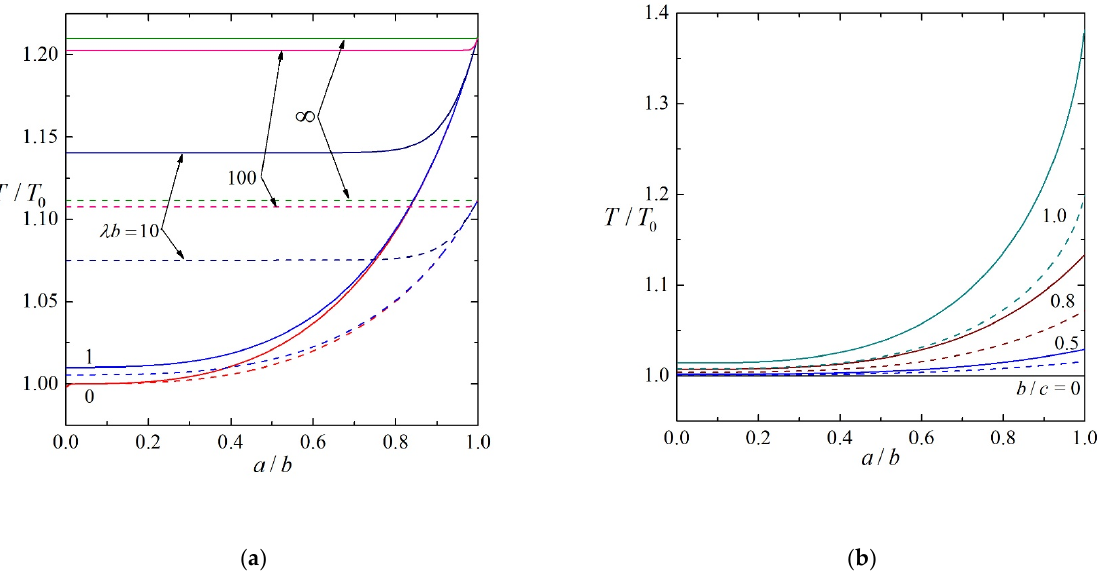
Figure 4. Normalized torque T / T 0 for a porous sphere ( a = 0) rotating about a diameter perpen- dicular to two planar walls vs. the relative position parameter c / ( c + d ) : ( a ) λ b = 10, where the dashed curves show given values of 2 b / ( c + d ) (the ratio of the particle diameter to the wall-to-wall distance); ( b ) b / c = 9/10.